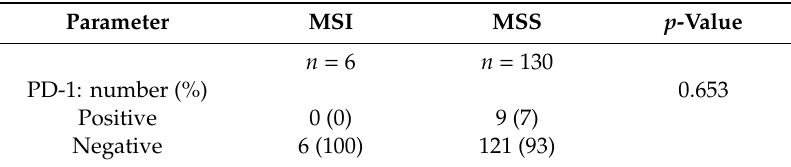
Table 4. Relationship between MSI status and PD-1 expression.